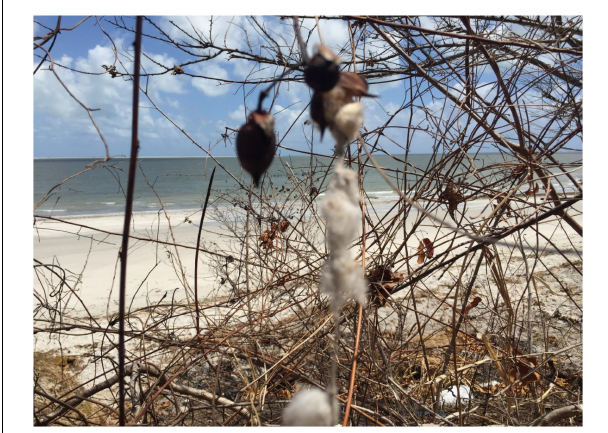
FIGURE 2 | Native cotton plant that has been burned, near the beach Pontal da Ilha, Itamaracá, Pernambuco, Brazil.